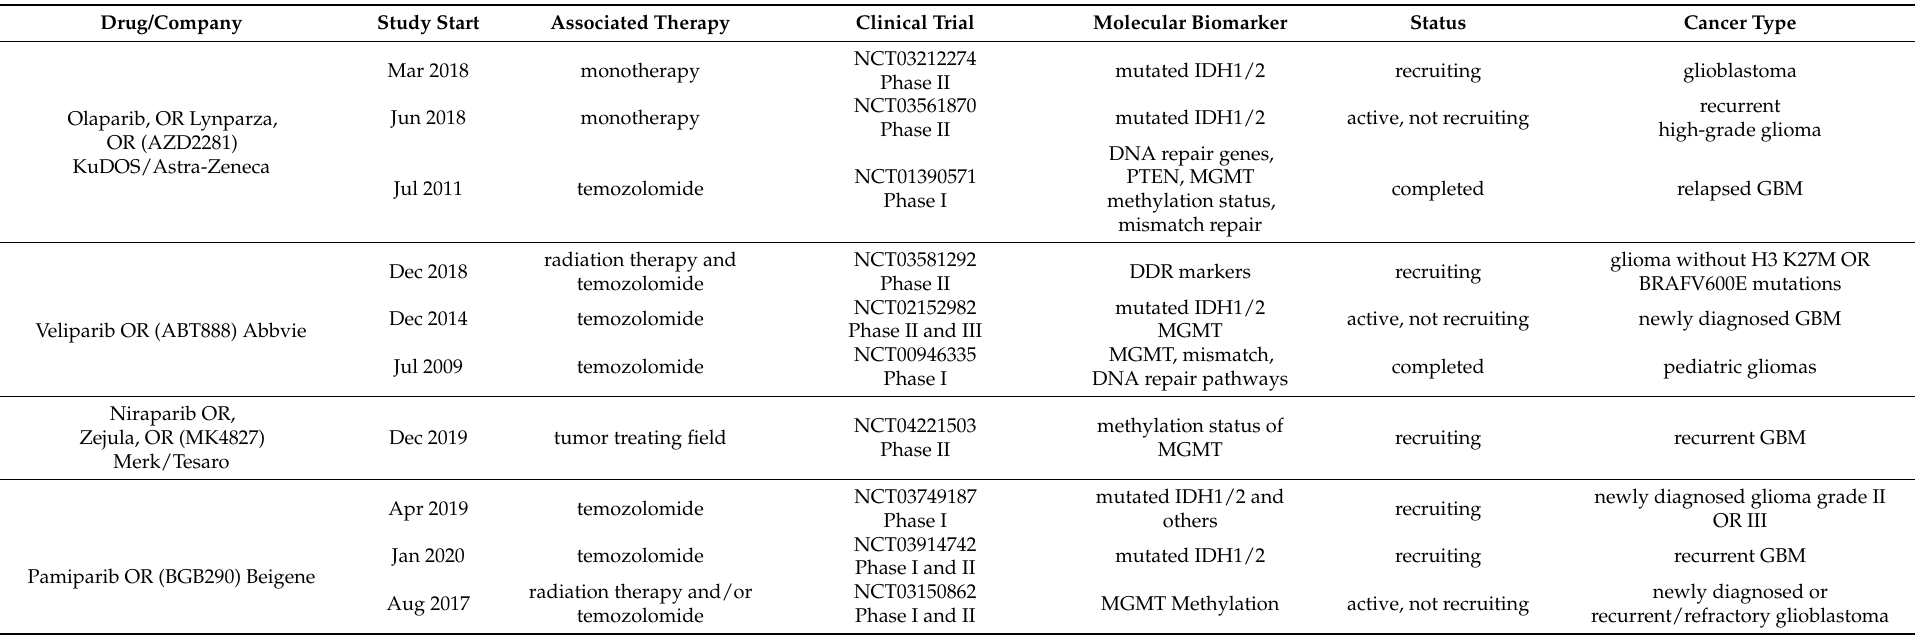
Table 1. Summary of clinical trials using PARPi that have used biomarkers for prediction of PARPi